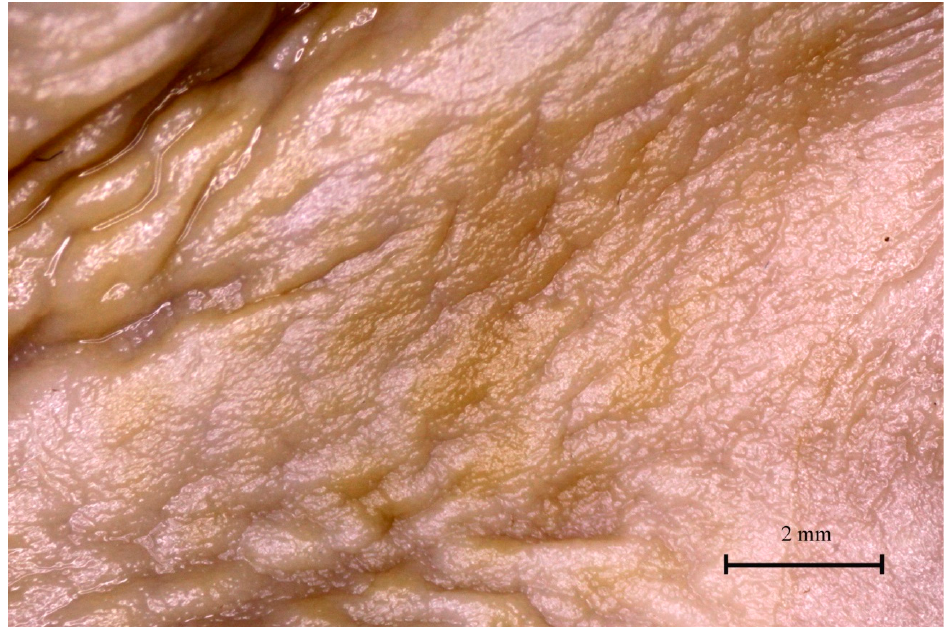
Figure 12. Gastric mucosa in the plicated edge margin region (the first age group). The difference between both parts of the stomach was distinguishable in the second age group and well visible in the third age group (Figures 13 and 14).